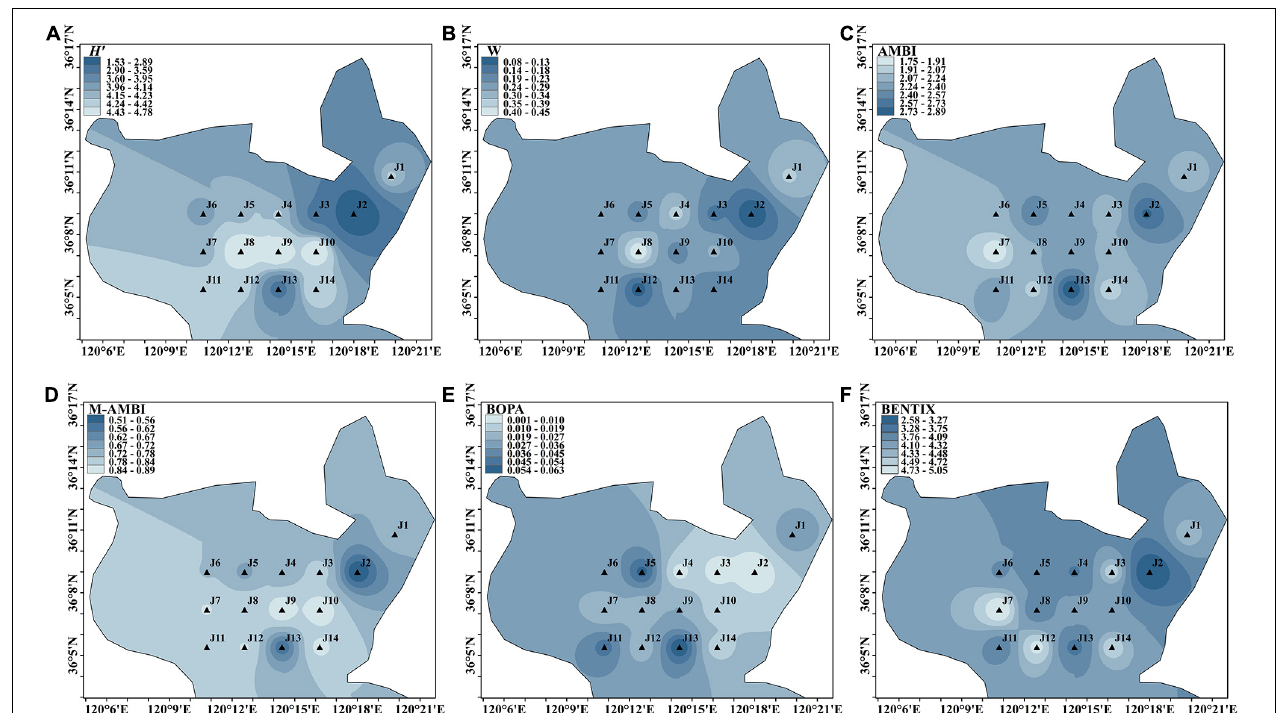
FIGURE 4 | Spatial distribution of environmental assessment in summer cruise in Jiaozhou Bay, H (cid:48) (A) , W (B) , AMBI (C) , M-AMBI (D) , BOPA (E) , and BENTIX (F) .